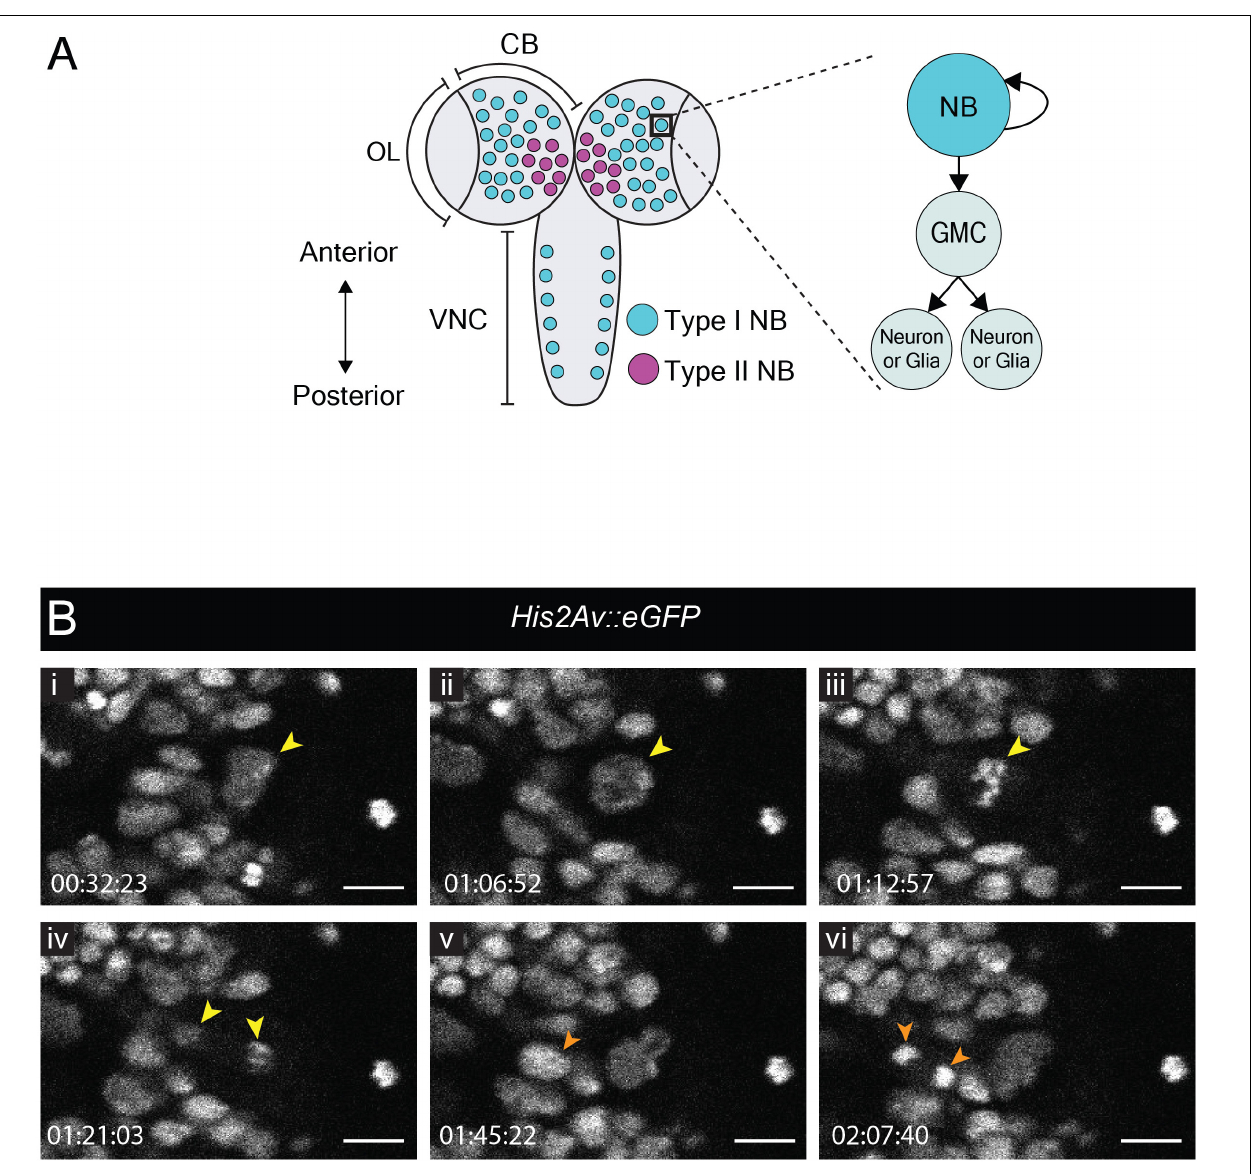
FIGURE 1 | Neuroblast and GMC divisions in the central brain during L3. (A) A schematic of the dorsal view of an L3 CNS, which is made up of the optic lobes (OL), the central brain (CB) and the ventral nerve cord (VNC) (Sousa-Nunes and Hirth, 2016). Type I neuroblasts (blue), which divide to self-renew and generate a GMC, are most abundant and are present throughout the CNS. GMCs divide symmetrically in size to generate two differentiating neuronal or glial progeny. Type II neuroblasts (magenta), defined by generation of two types of transit-amplifying progenitors (intermediate neural precursors and GMCs) consist of eight paired lineages found in the dorsoposterior regions of the CB. The black box indicates the region selected for live imaging, which contains only type I neuroblasts. (B) A time-series extracted from Movie 1 showing a cultured His2aV::eGFP brain (wL3) with a Type I neuroblast nucleus (yellow arrowhead) and a GMC nucleus (orange arrowhead) undergoing cell divisions. Timescale displayed as hh:mm:ss, scale bar = 10 µ